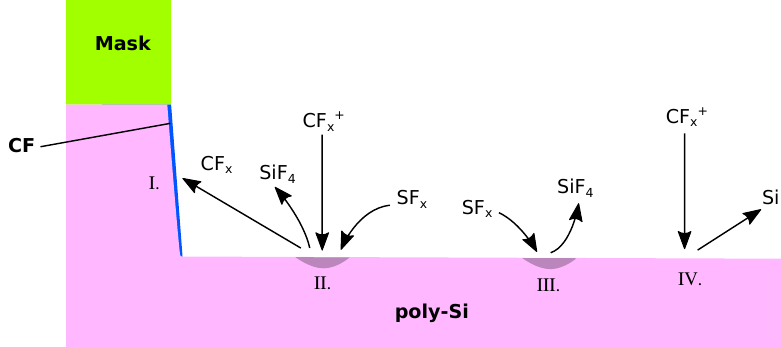
Figure 14. Sulfur with Fluoride (SF) type etching and deposition mechanics with additional CH 2 F 2 feed gas. I. Line of sight deposition of a CF passivation layer; II. ion-enhanced etching; III. chemical etching; and IV. physical ion sputtering.